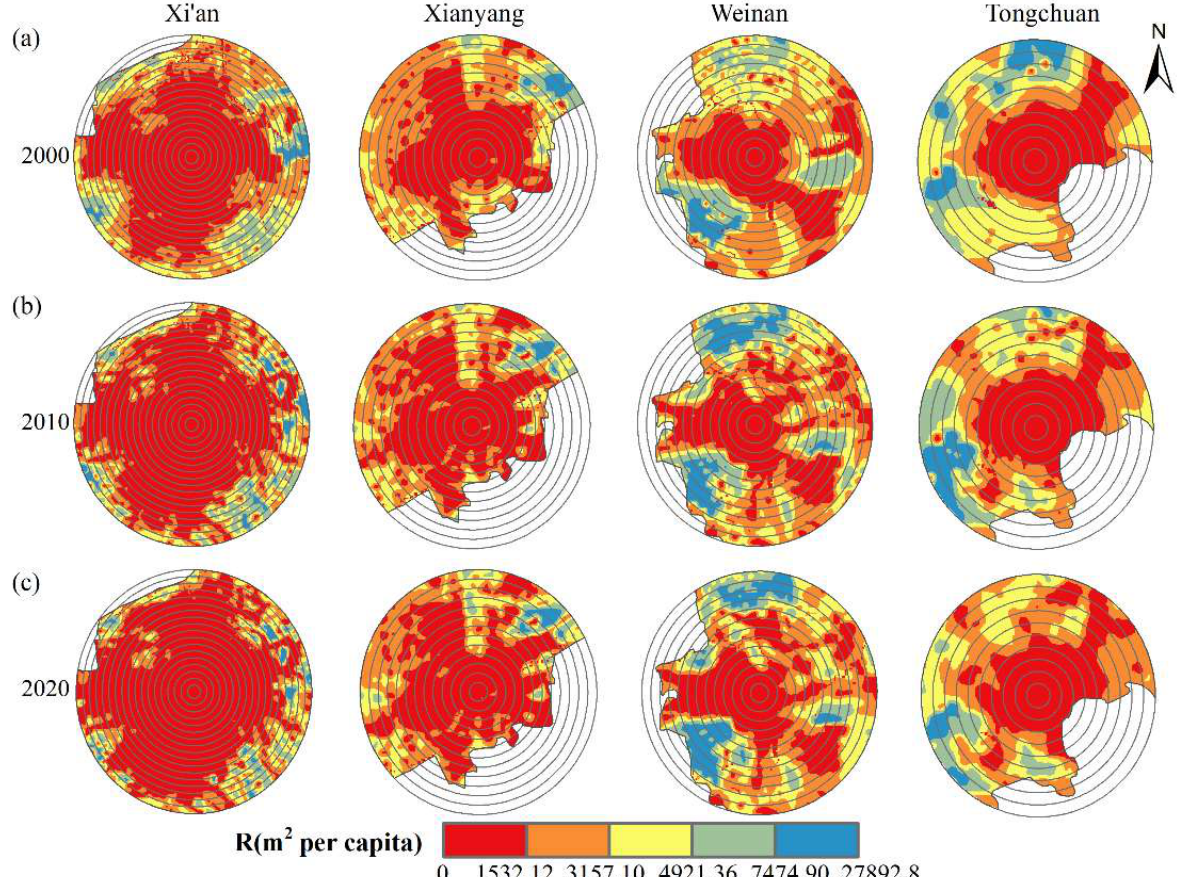
Figure 6. Spatio-temporal dynamic maps of recreation (R) in ( a ) 2000, ( b ) 2010, and ( c ) 2020 in the XMA (unit: m 2 per person).